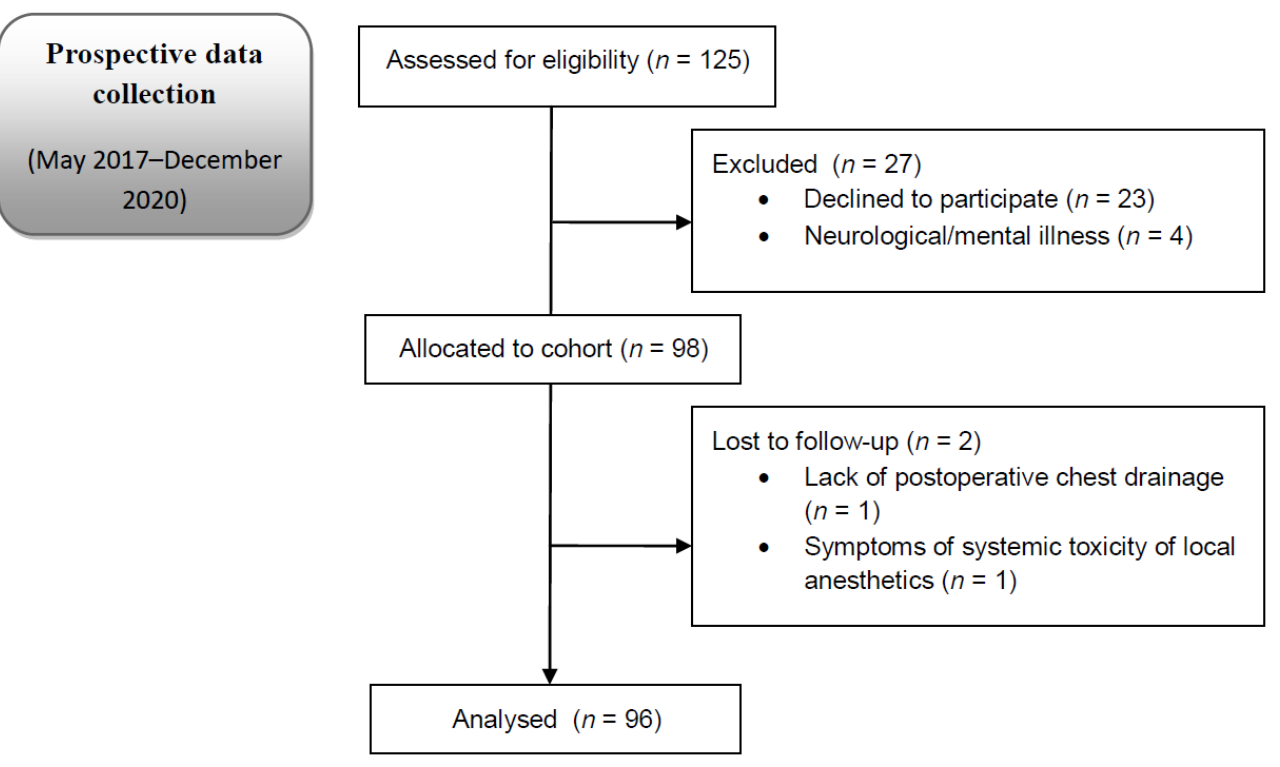
Figure 1. Flow diagram. Table 2. Demographic and clinical characteristics of the study